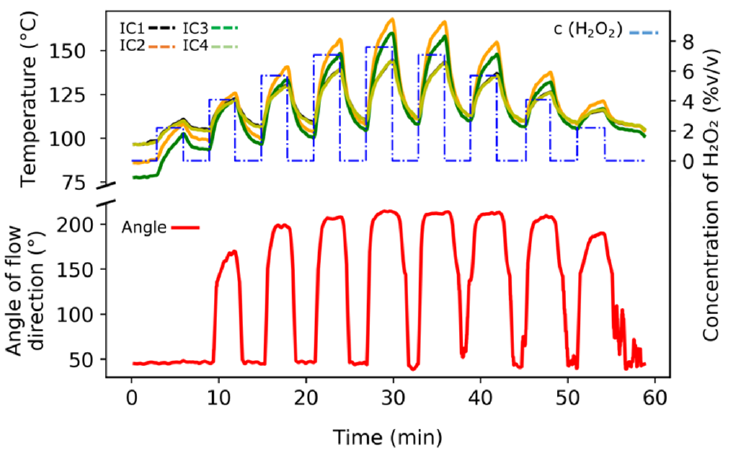
Figure 6. Assessing the change of gas flow direction under a H 2 O 2 flow rate of 8 m 3 /h at 270 °C. It is noticeable that the temperature curves are slightly different, which illustrates the direction dependence of the flow. A similar behavior was found for a flow rate of 12 m 3